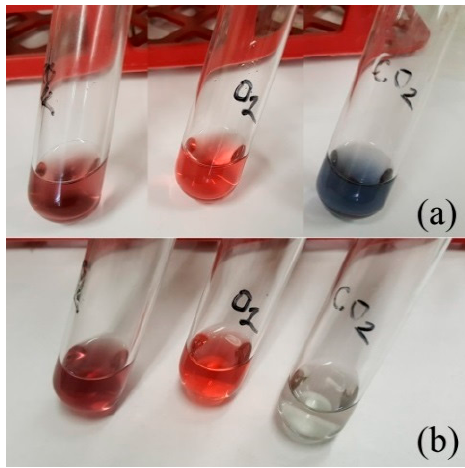
Figure 3. The effect of atmospheric gases on the stability of 10 nm Au sol in diethanol amine-containing solutions (from left to right: Ar, O 2 , CO 2 ): ( a ) 15 min and ( b ) 4 days after being in contact with the given gas. Oxygen preserved the original color, and carbon dioxide led to aggregation in minutes and the settling of the micron-sized large particles in 4 days.